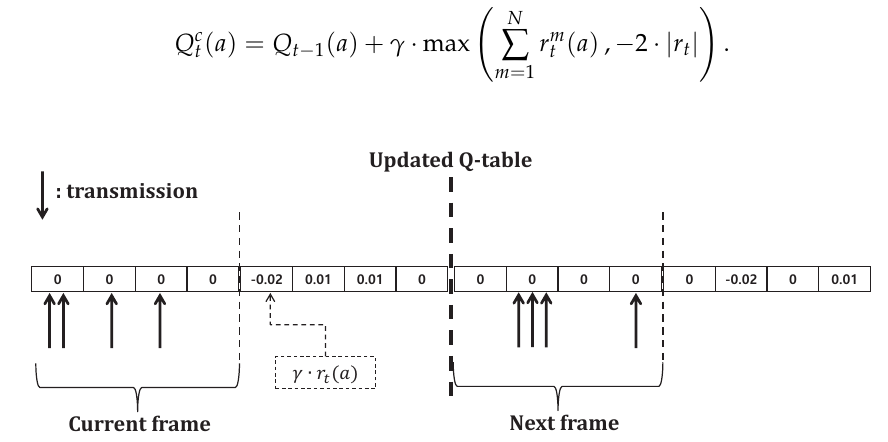
Figure 1. Example of calculation process and repeating